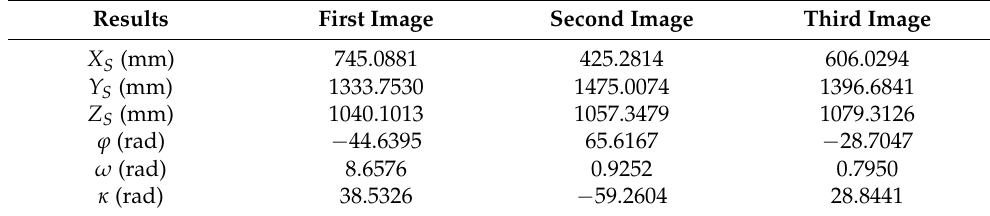
Table 14. Exterior orientation elements of three images.